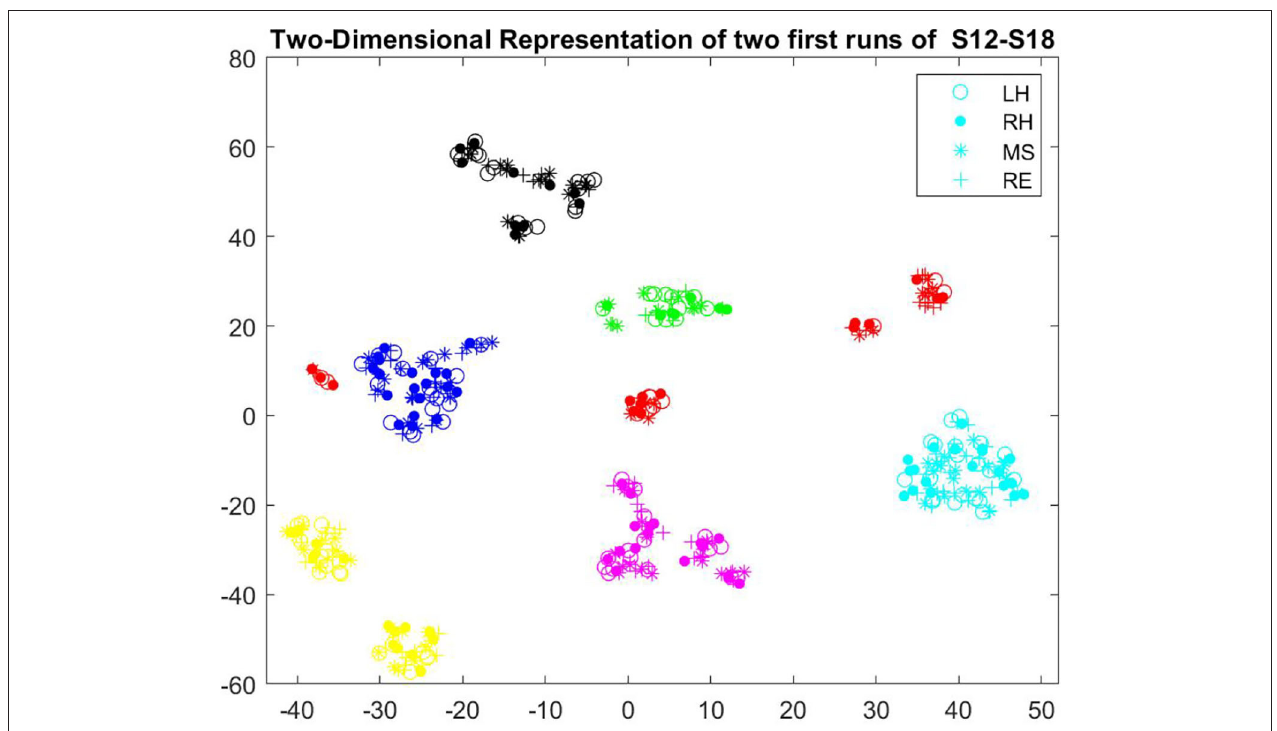
FIGURE 5 | Two-dimensional representation of SCMs, projected by t-SNE, recorded in two first runs of sessions 12–18 (different sessions are illustrated in different colors, S12:green, S13: blue, S14: black, S15:magenta, S16: yellow, S17: red, S18: